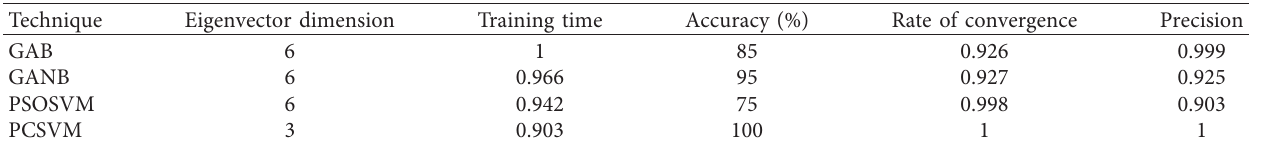
Figure 12: The fitting diagram of PCSVM. Table 4: Performance comparison of